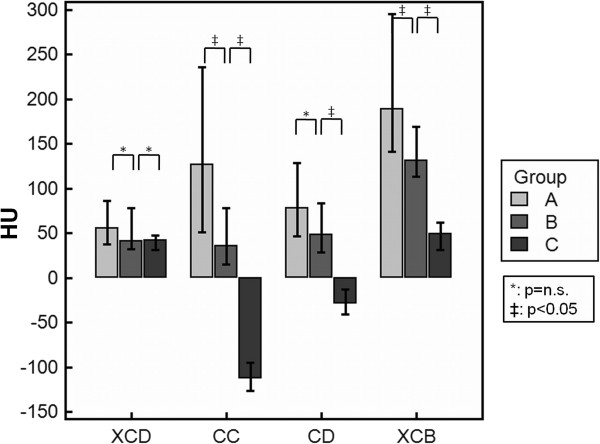
Attenuation. Attenuation values as provided by the different reconstruction kernels. Note that with increasing stent size the values of the CC and CD kernels become negative.